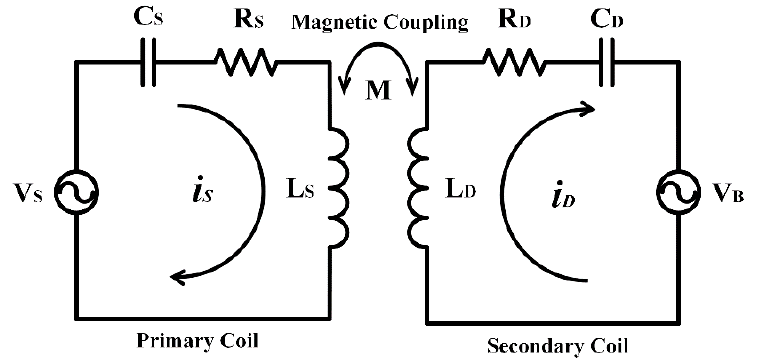
Figure 1. LC ‐ LC series topology. Figure 1. LC-LC series